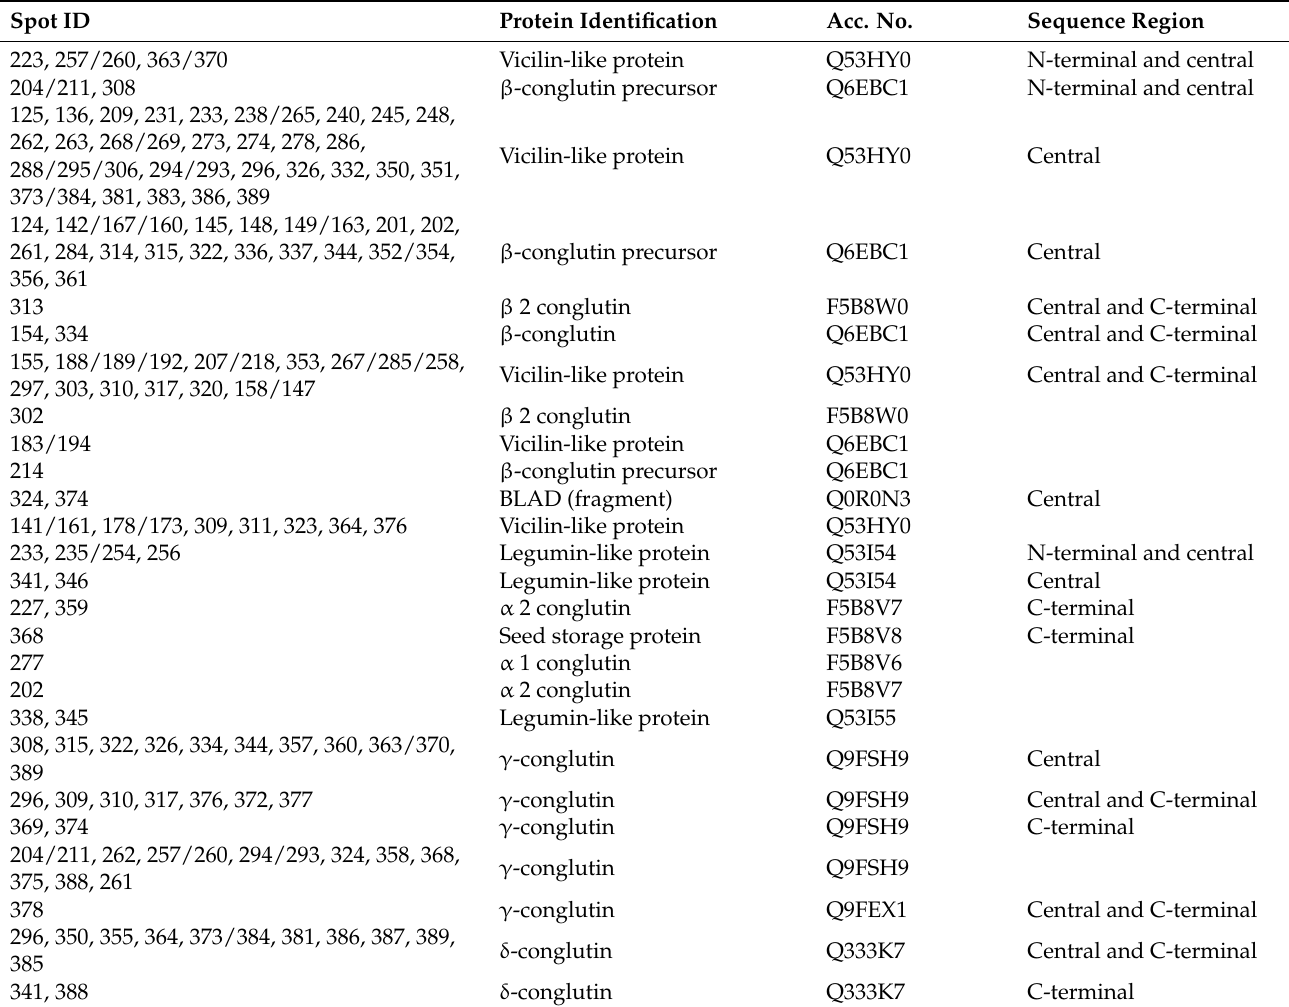
Table 8. List of conglutins identified in the Luxor cultivar ( Lupinus albus ). Spots were grouped according to the identified amino acid sequence